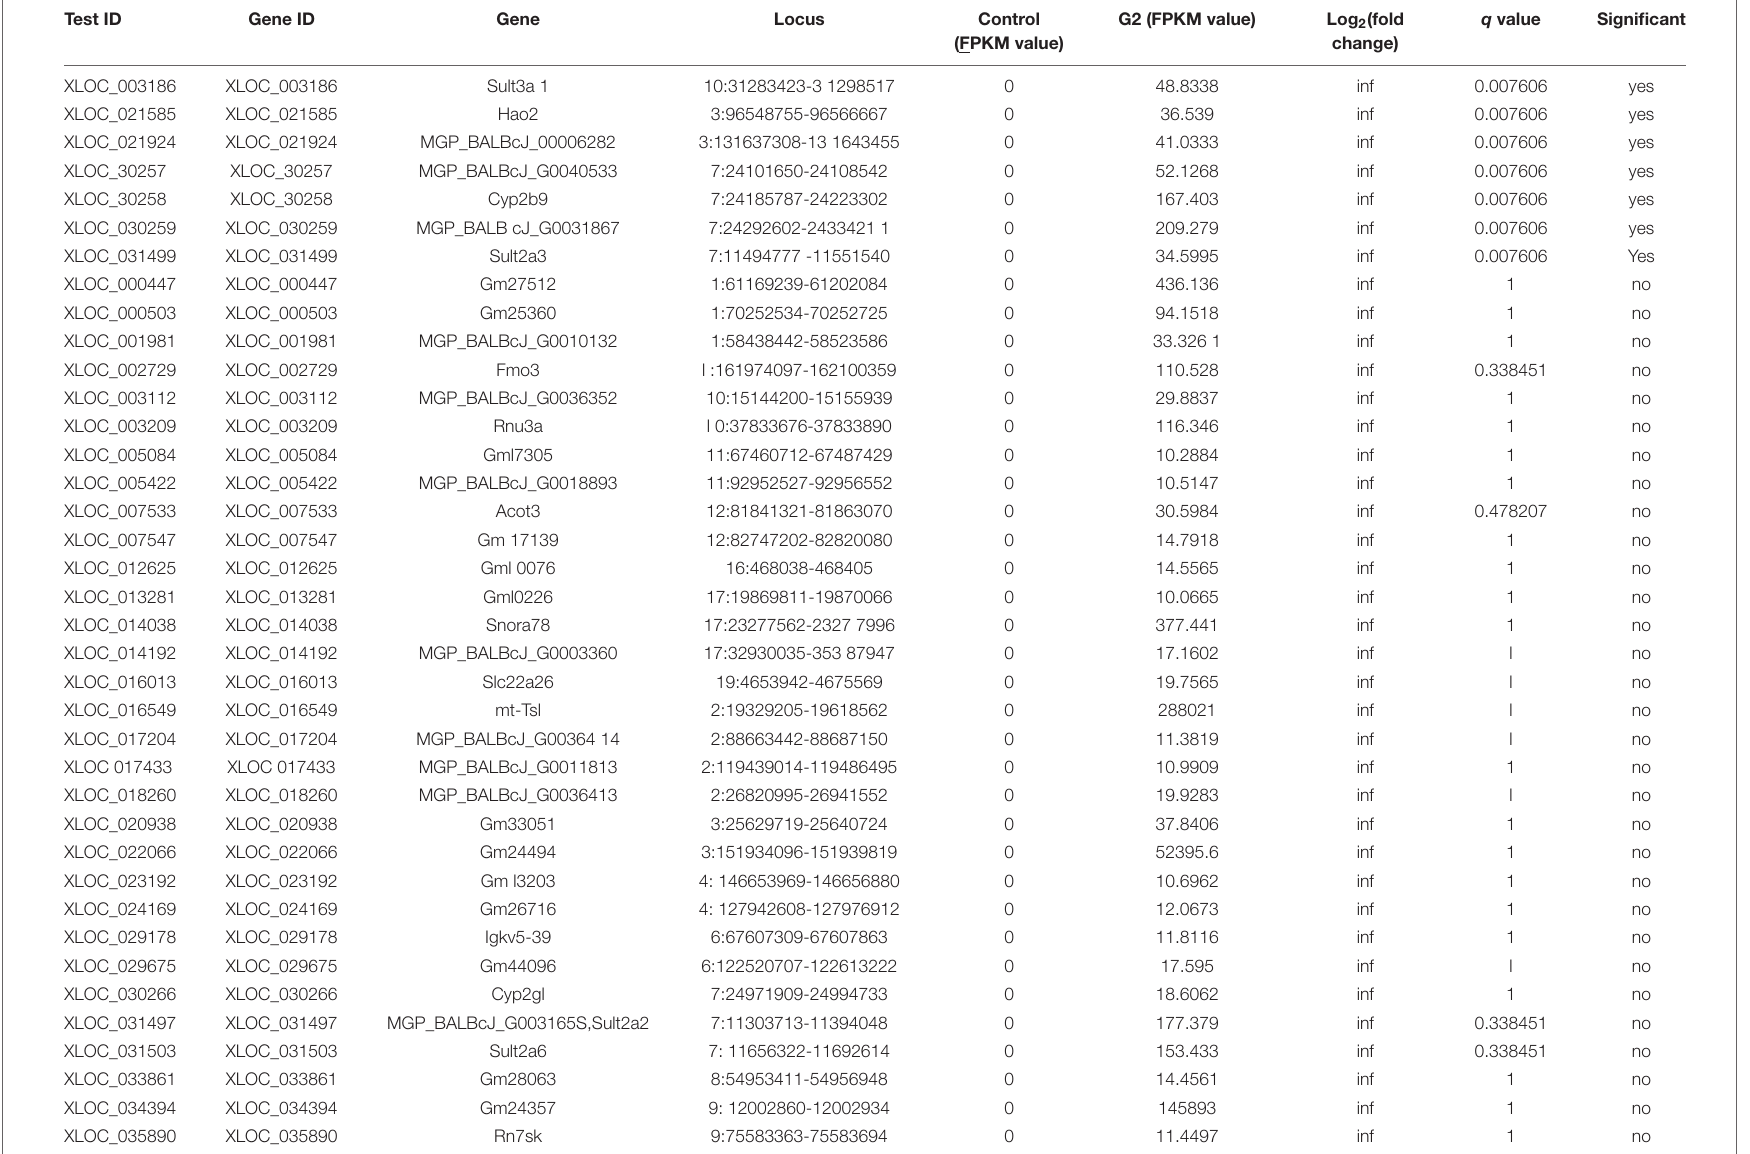
TABLE 2 | Novel gene expression in DVI-SCT group compared to DVI group (novel gene expression triggered by stem cell